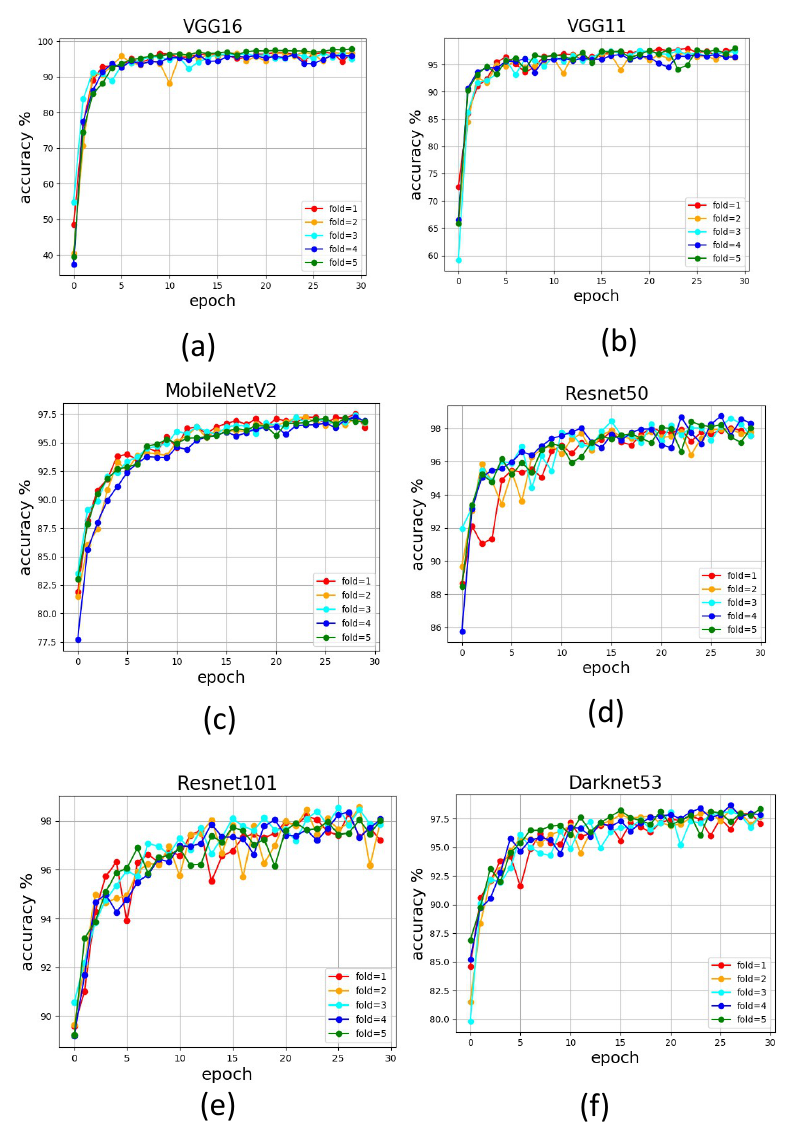
Figure 6. The accuracy profile for different classification models trained using curated dirt dataset; VGG-16 ( a ), VGG-11 ( b ), MobileNetV2 ( c ), Resnet50 ( d ), Resnet101 ( e ), Darknet53 ( f